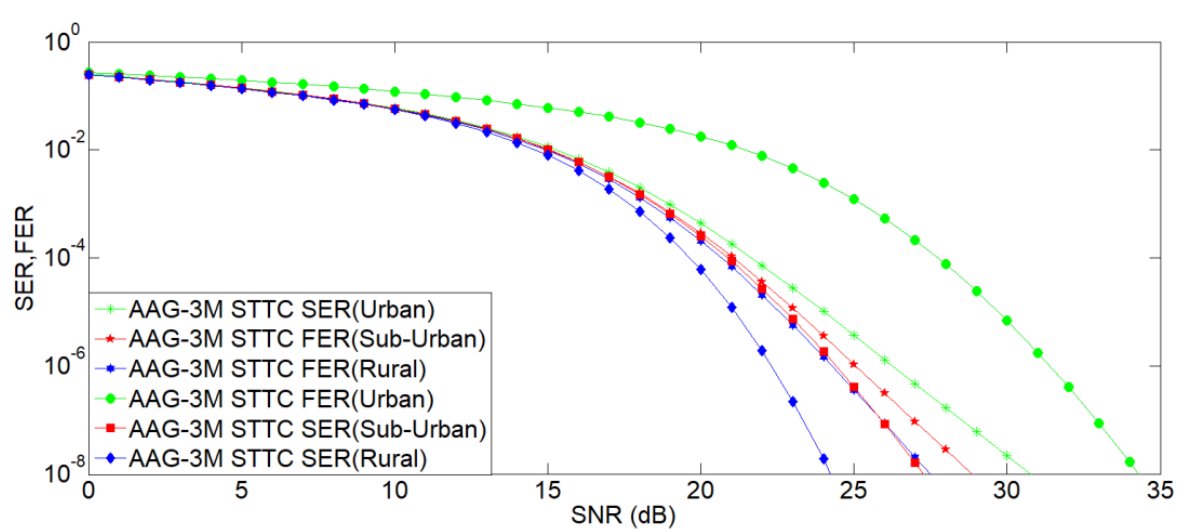
Figure 4. Comparison of urban, suburban, and rural deployment for AAG-3M STTC in terms of FER and SER.